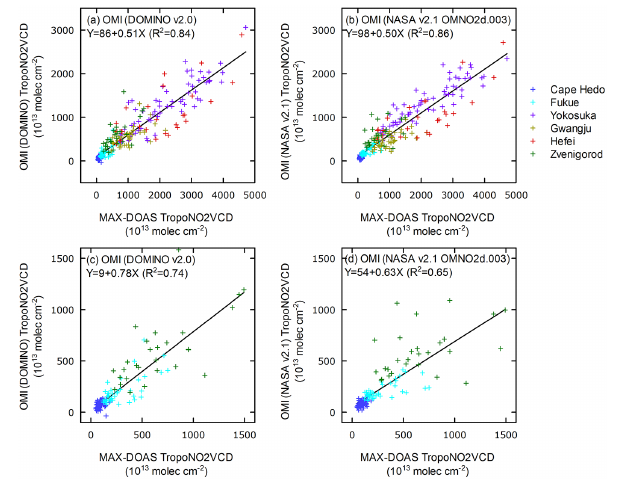
Figure 8. Scatterplots between monthly averages of Tro- poNO2VCD derived from OMI and MAX-DOAS for all sites (a, b) , and for three rural/remote sites (c, d) , using DOMINO ver. 2.0 for (a) and (c) , and NASA ver. 2.1 for (b) and (d)